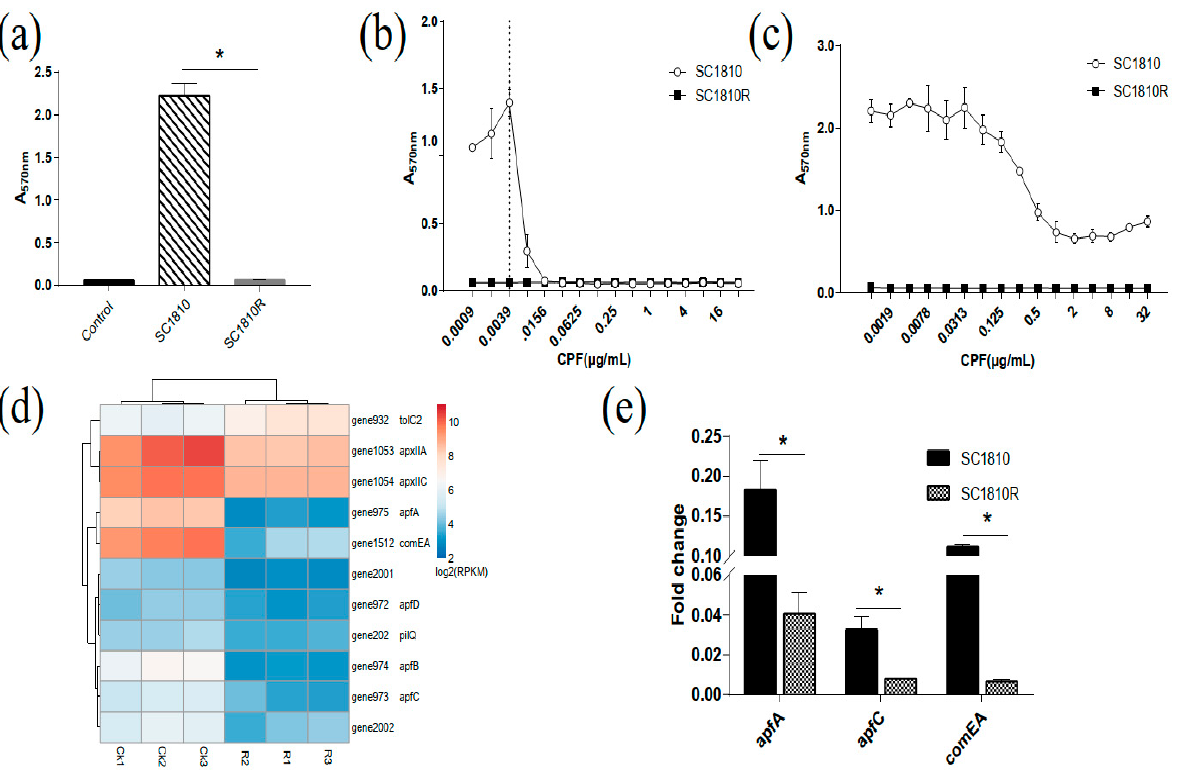
Figure 3. Antibiofilm activity of CPF on SC1810. ( a ) Biofilm biomass of wild-type and mutant strain (* p < 0.05). ( b ) Effects of CPF on biofilm formation (12 h with drug, n = 3) and ( c ) eradication at different concentrations (12 h without drug, 12 h with drug, n = 3), respectively. The data are shown as the absorbance at 570 nm (A570 nm) of residual biofilm and associated error bars denote the standard error of the mean. ( d ) Analysis of differentially expressed genes (DEGs) related to pili formation between wild-type strains and mutants. ( e ) Relative transcription levels of apfA , apfC and comEA determined using qRT-PCR. Data are expressed as the mean and standard deviation (SD) of 3 experiments (* p < 0.05).